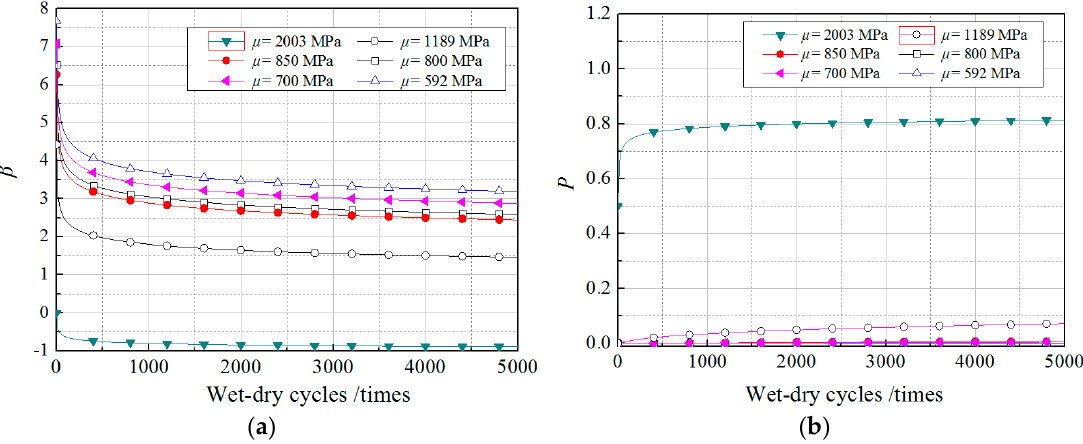
Figure 8. The effects of mean of the load on the GFRP specimens: ( a ) Change of β with wet-dry cycles; and ( b ) change of P with wet-dry cycles.